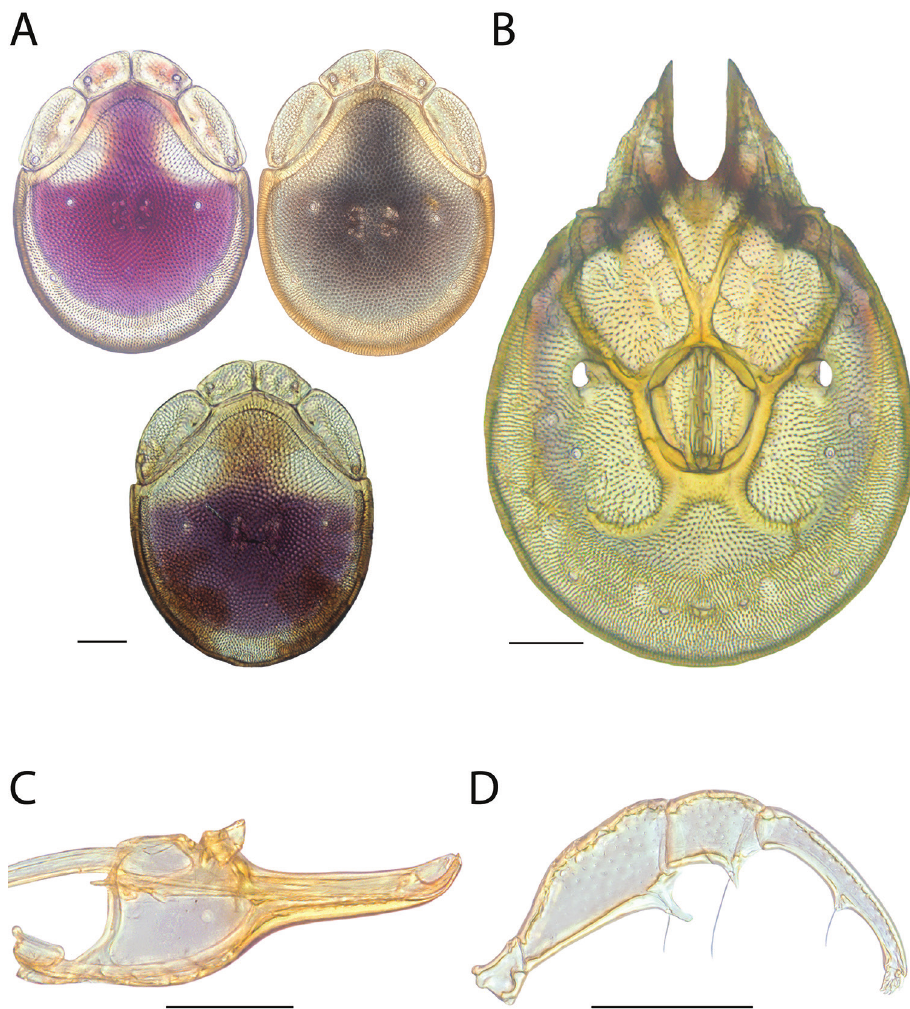
Figure 212. Torrenticola raptor sp. n. female: A dorsal plates, note color variation B venter (legs re- moved) C subcapitulum D pedipalp (setae not accurately depicted). Scale = 100 µm.